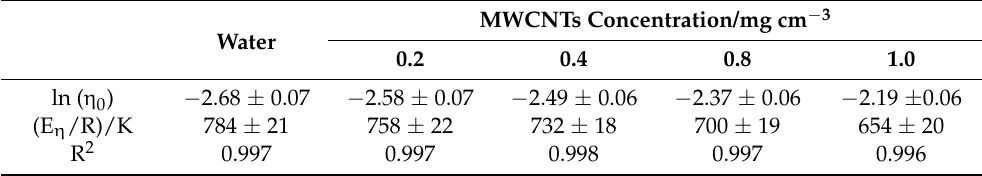
Table 5. Viscosity–temperature model parameters for MWCNTs dispersed in